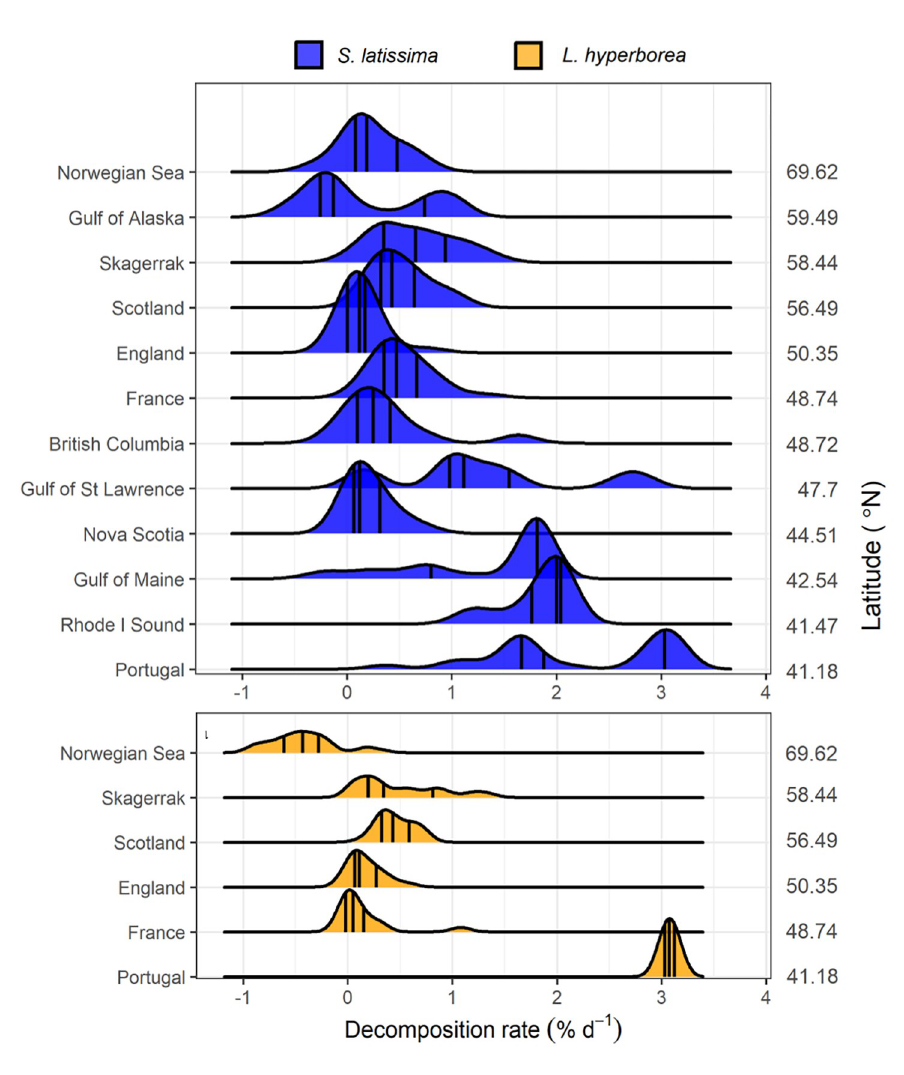
Fig 2. Kelp decomposition rates across study regions. Probability density functions of decomposition rates of (A) Saccharina latissima and (B) Laminaria hyperborea throughout the northern hemisphere (Data B in S1 Data). Curves show frequency of observations, pooled across sites in each region and ordered by latitude. Black middle lines show medians, and outer lines show the 25th and 75th quantiles. Y axes units are the proportion of observations, ranging from 0 to 1, with the height of each site panel showing 0 to 0.18 (A) and 0 to 0.9 (B).